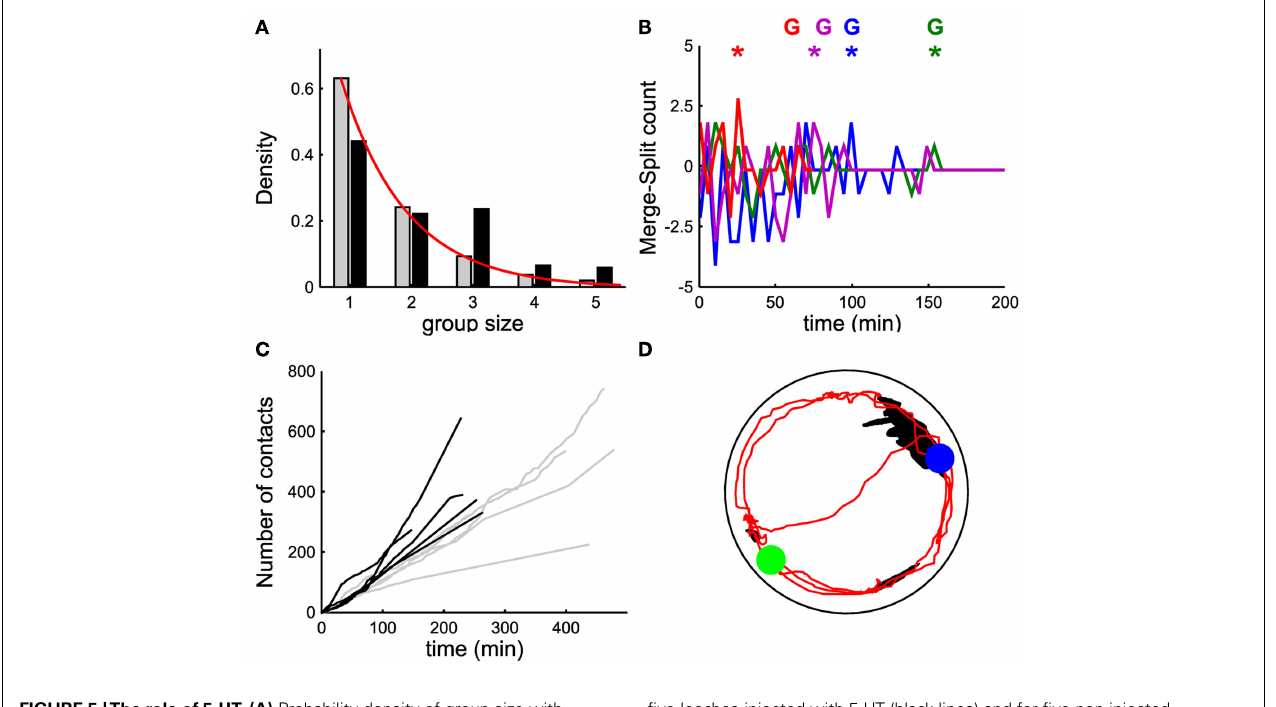
FIGURE 5 |The role of 5-HT. (A) Probability density of group size with five non-injected leeches (gray bars) and with five leeches injected with 300 μ l of 200 μ M 5-HT solution (black bars). (B) Time evolution of the difference between merges and splits [i.e., M ( i Δ t ) − S ( i Δ t )] in a window Δ t of 5min for four experiments with five leeches injected with 5-HT; colored asterisks mark the occurrence of a peak of merges leading to the formation of a stable group, marked with the letter G (same color). (C) Time evolution of number of contacts per minute (cumulative sum) for